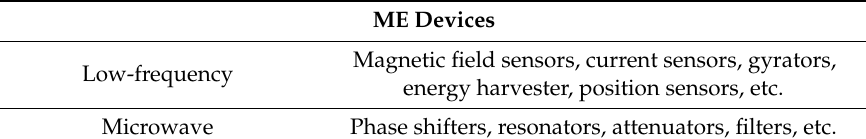
Table 1. Application of magnetoelectric e ff ect (ME)